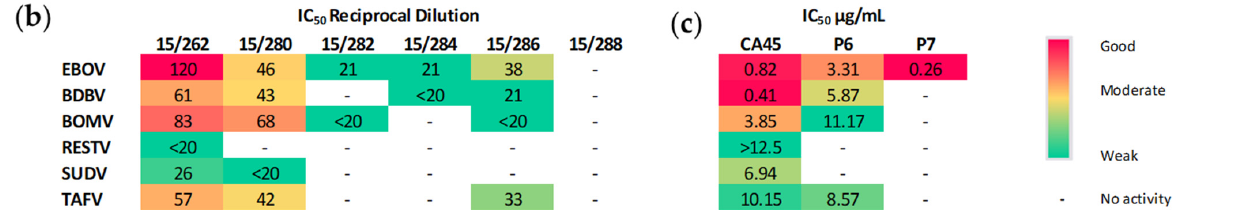
Figure 5. Cross-neutralisation of BOMV afforded by a panel of human EBOV convalescent serum and monoclonal antibodies. ( a ) Dose-response curves plotted as percentage neutralisation for dilutions of the WHO IS (15/262) and WHO Reference Panel members from four individuals recovered from EBOV (15/280, 15/282, 15/284, 15/286) and a negative control (15/288) along with two pan-ebolavirus mAbs (CA45, P6) and an EBOV-specific mAb negative control (P7). ( n = 2) ( b , c ) 50% inhibitory concentrations (IC 50 ) expressed as reciprocal of the dilution factor for plasma samples ( b ) or in μ g/mL for mAb ( c ); IC 50 were interpolated via non-linear regression analysis, with potency ranked good to weak based on a 50th percentile mid-point. Where the IC 50 is outside the dilution range tested, values are reported as greater or less than the minimum serum (1:20) ( b ) and mAb (12.5 μ g/mL) ( c ) dilution tested.